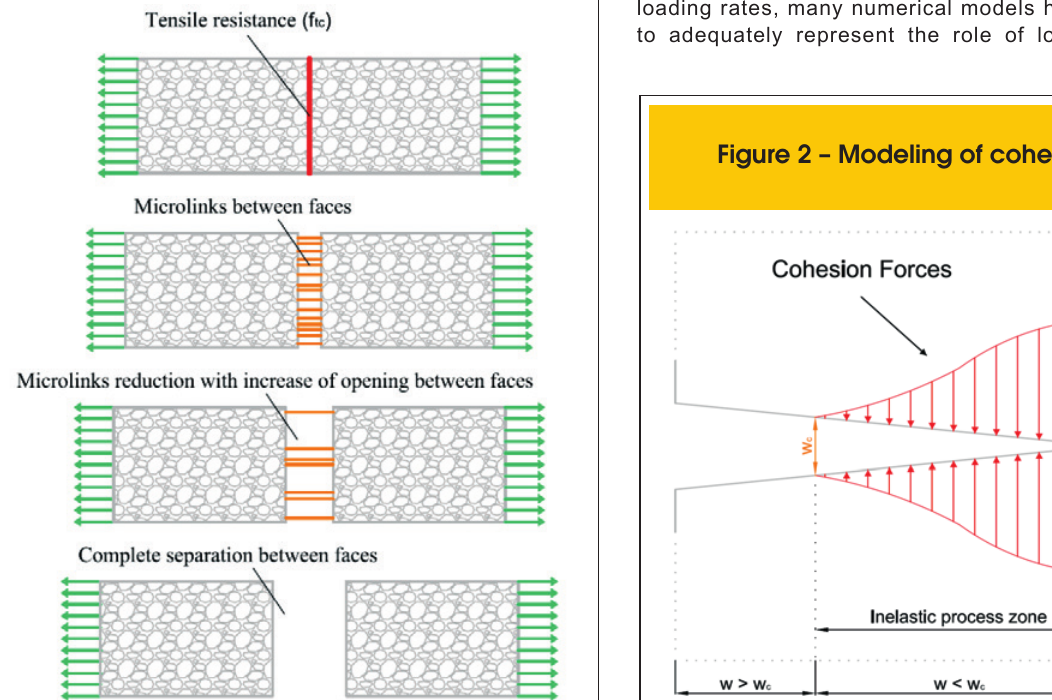
Figure 1 – Representation of the softening process between the crack faces in concrete